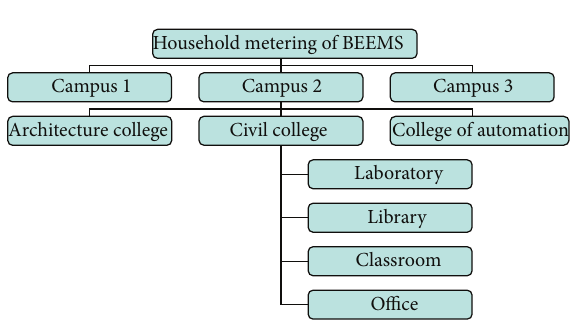
Figure 18: Household metering method of the ZBEMCS according to each